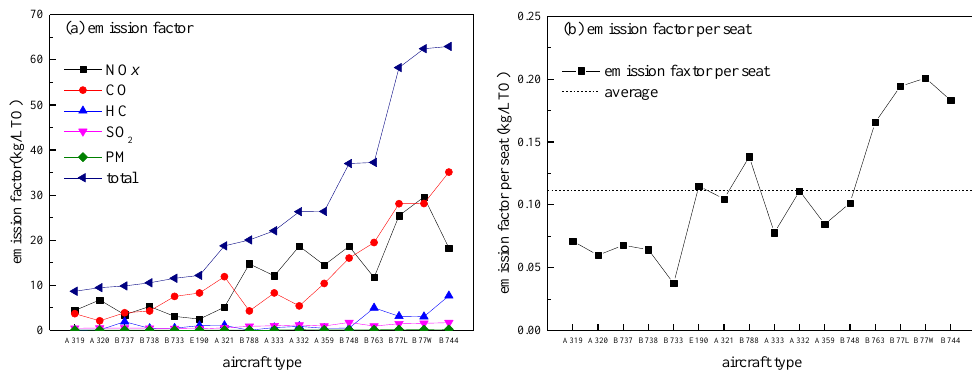
Figure4. Theaircraft( a )emissionfactorsand( b )totalemissionfactorsperseatfordi ff Figure 4. The aircraft ( a ) emission factors and ( b ) total emission factors per seat for different aircraft